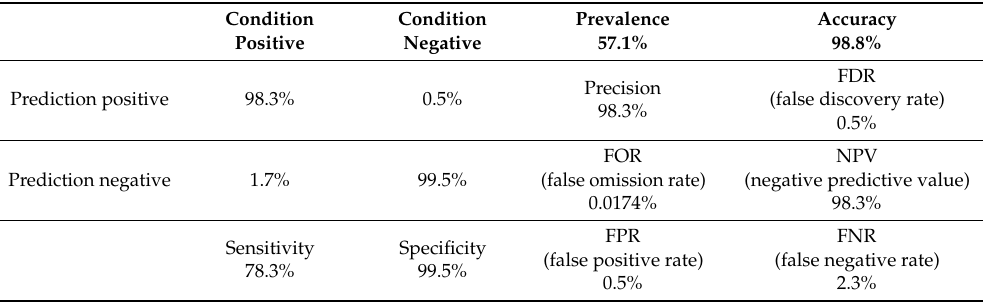
Table 3. Confusion matrix for 11 spectra